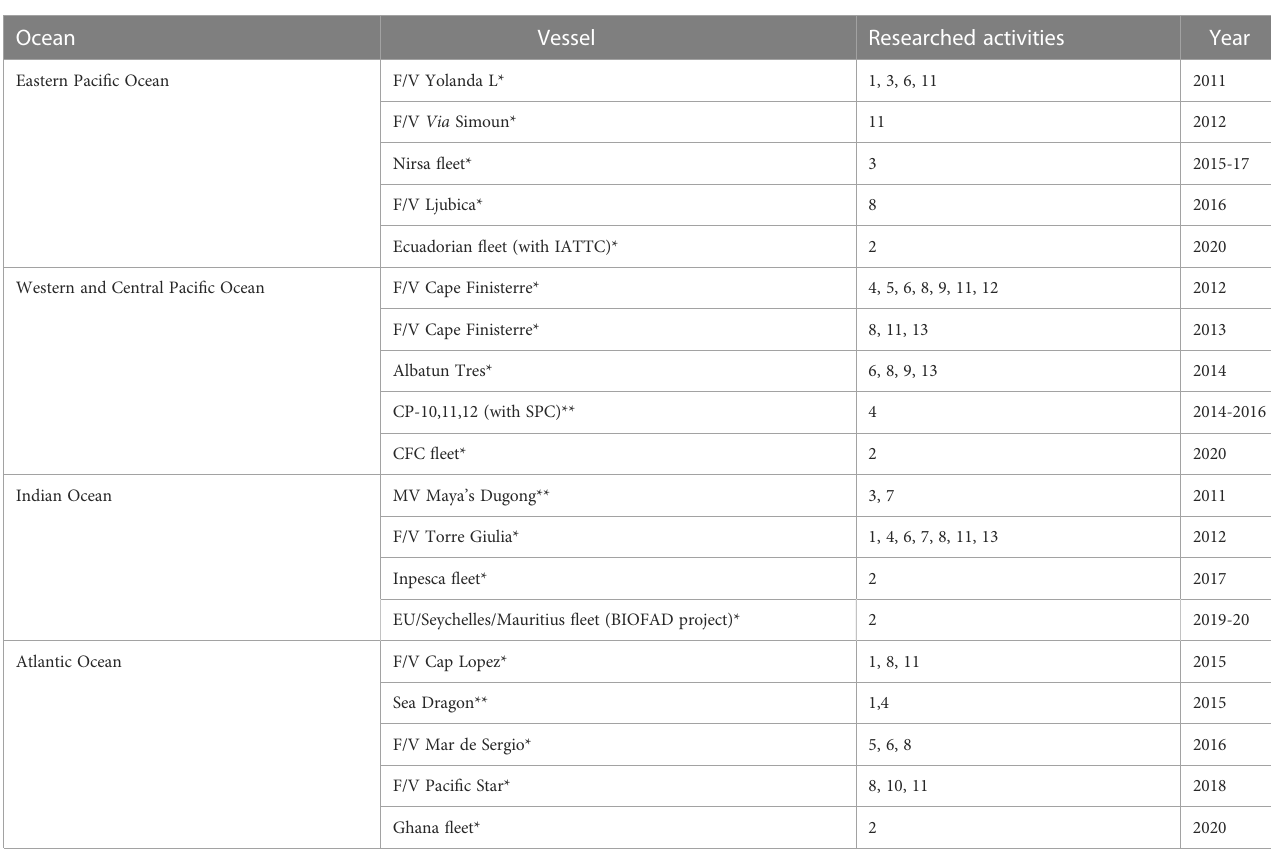
TABLE 4 Tuna purse seine fi shery ISSF-related research cruises testing mitigation activities between 2011-2020, namely (1) non-entangling FAD designs, (2) deployment and data collection of non-entangling biodegradable FADs, (3) deployment and data collection of shallow vs deep FADs to study effect on bigeye tuna catches, (4) behavior of tunas and other species around FADs, (5) behavior of tunas and other species in the net, (6) improving pre-set estimation of species, sizes and quantities associated to FADs with acoustics, (7) avoiding catch of sharks before setting, (8) releasing sharks and other vulnerable species from the net, (9) releasing undesirable sizes of yellow fi n and bigeye tuna from the net, (10) releasing sharks and other vulnerable species from onboard the vessel, (11) post-release survival of vulnerable species, (12) improving monitoring capabilities onboard, (13) fundamental biology research of FAD aggregated